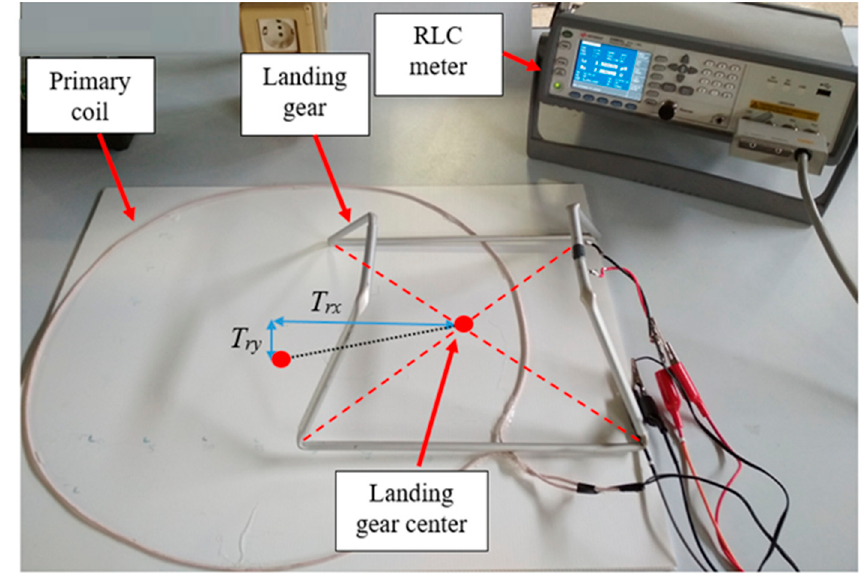
Table 1. Calculated and measured circuit lumped parameters for the primary coil with N 1 = 1 and for the secondary coil/landing gear with N 2 = 1.